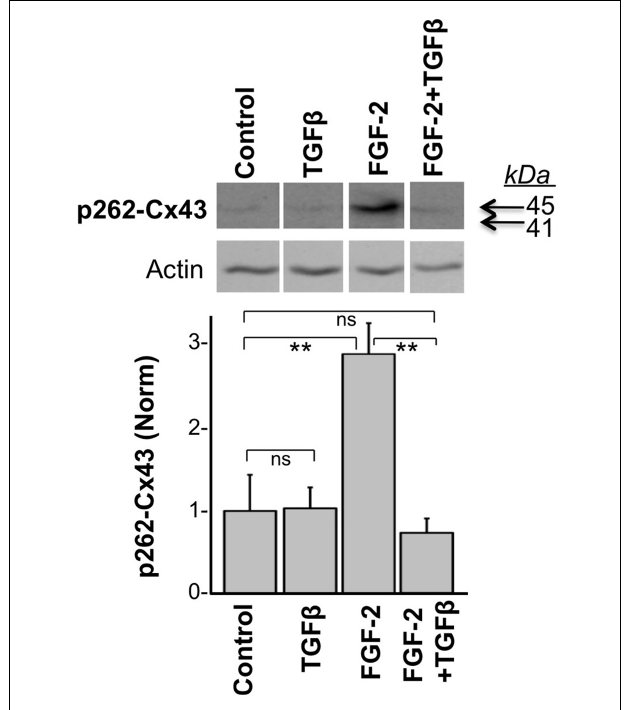
FIGURE 2 |TGF β prevents the FGF-2-induced stimulation of Cx43 phosphorylation at S262. Representative western blots of cardiomyocyte cultures stimulated with FGF-2 (10 ng/ml) in the absence or presence of TGF β pre-treatment for 15 min, as indicated. Corresponding normalized densitometry-based data are also included. ** and ns correspond to P < 0.01, or P > 0.05; n =